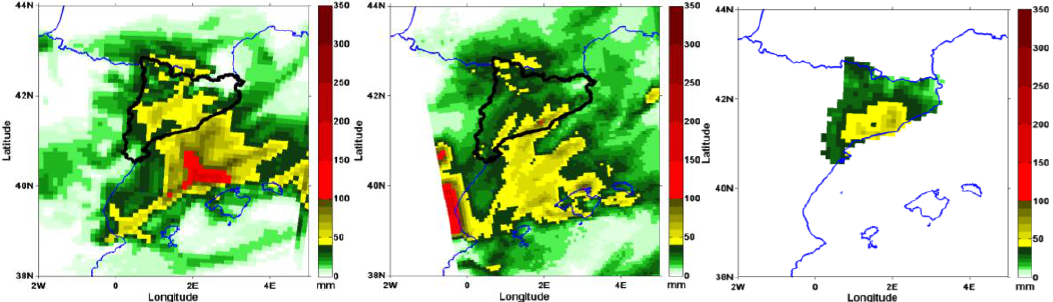
Fig. 16. MM5’s QPF (left), COSMO-I7’s (centre) and observed rainfall (right) for the 28–29 October 2008 event (case study 5). For clarity, the observations domain limit has been highlighted (black line) in the models’ prediction maps.